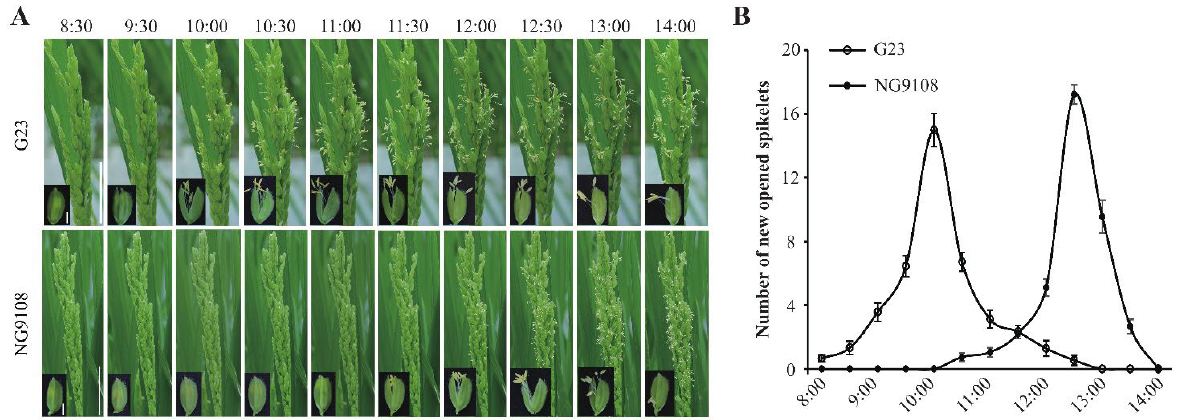
Figure 1. Dynamics of FOT in both G23 and NG9108. ( A ) Characteristics of FOT in G23 (top) and NG9108 (bottom) during the daytime. The scale bar of the panicles equals 5 cm. The bar for single florets is 2 mm. ( B ) Statistics of the newly opened florets in a 30 min interval from 8:00 to 14:00 in G23 and NG9108. Bars indicate the mean ± standard deviation.